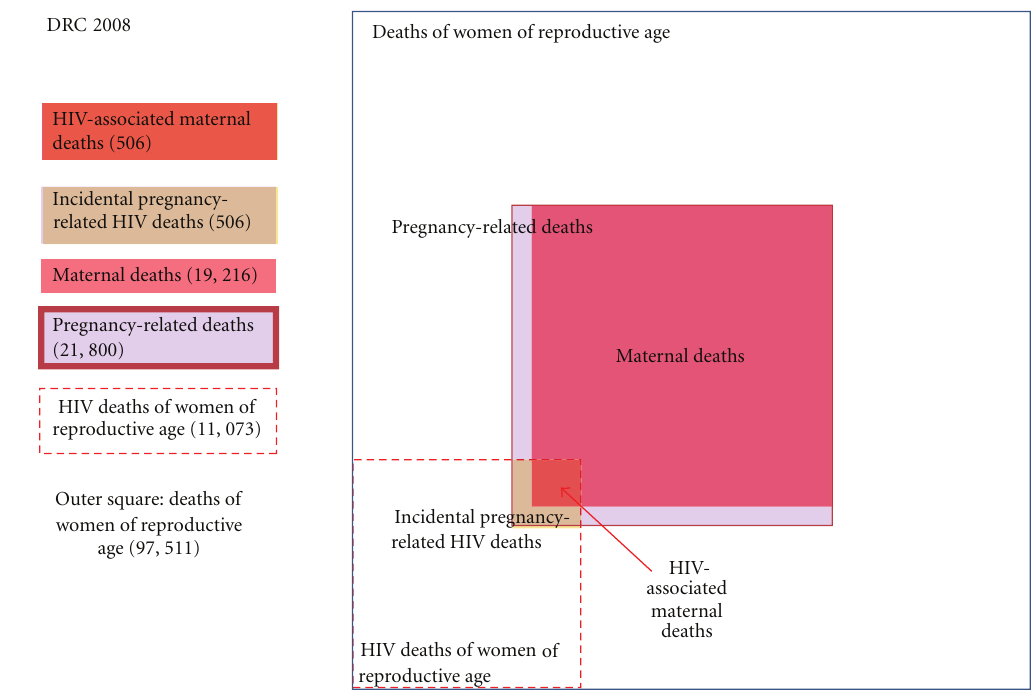
Figure 3: Intersection of HIV and maternal mortality in DRC, 2008. Source: http://www.who.int/gho/maternal health/mortality/